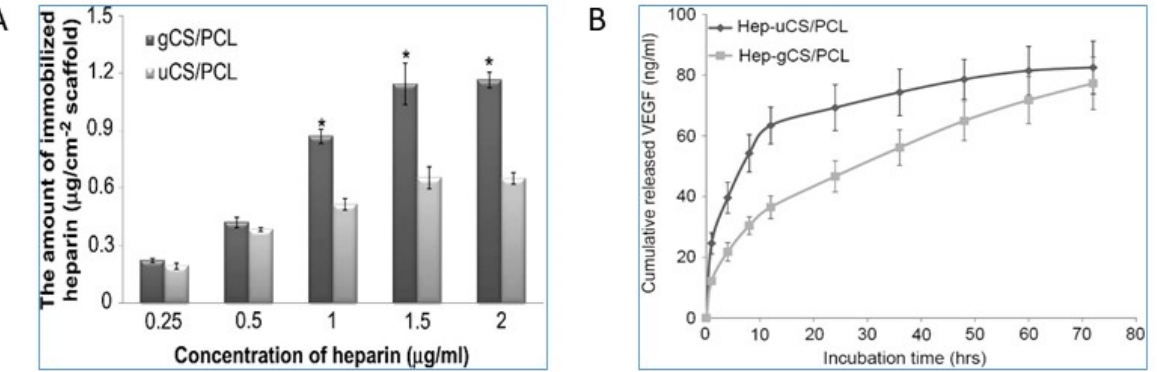
Figure 3. Comparison of the gradient and uniform CS/PCL in the cardiac tissue regeneration [29]. ( A ) Heparinization of the uniform CS/PCL (uCS/PCL) and gradient (gCS/PCL); ( B ) Cumulative release of VEGF from heparinized-uniform CS/PCL (Hep-uCS/PCL) and heparinized-gradient CS/PCL (Hep-gCS/PCL). Values represent mean ±SD ( n = 5). “*” indicate statistically significant differences compared to heparinized groups ( p < 0.05).